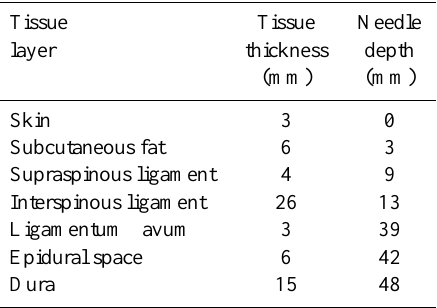
Table 2. Data from porcine trial (tissue thickness of each layer was measured at L2 / L3). Tissue Tissue